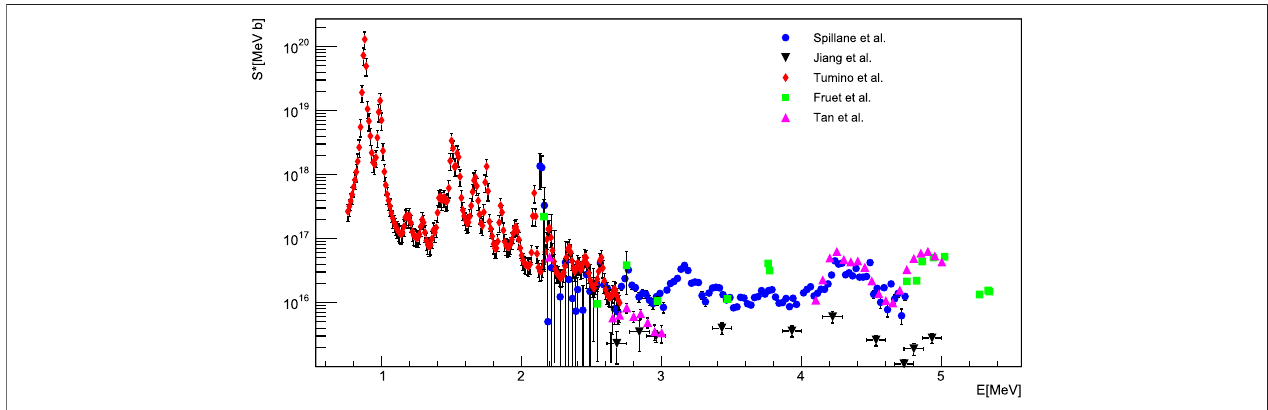
FIGURE 9 | S-factor values obtained by Spillane et al. (2007), Jiang et al. (2018), Tumino et al. (2018a), Tumino et al. (2018b), Fruet et al. (2020), and Tan et al. (2020).